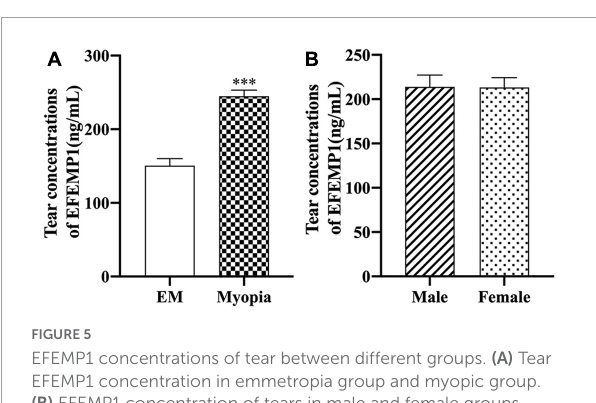
FIGURE5 EFEMP1 concentrations of tear between different groups. (A) Tear EFEMP1 concentration in emmetropia group and myopic group. (B) EFEMP1 concentration of tears in male and female groups. ∗∗∗ p < 0.001, compared with EM group. EM,